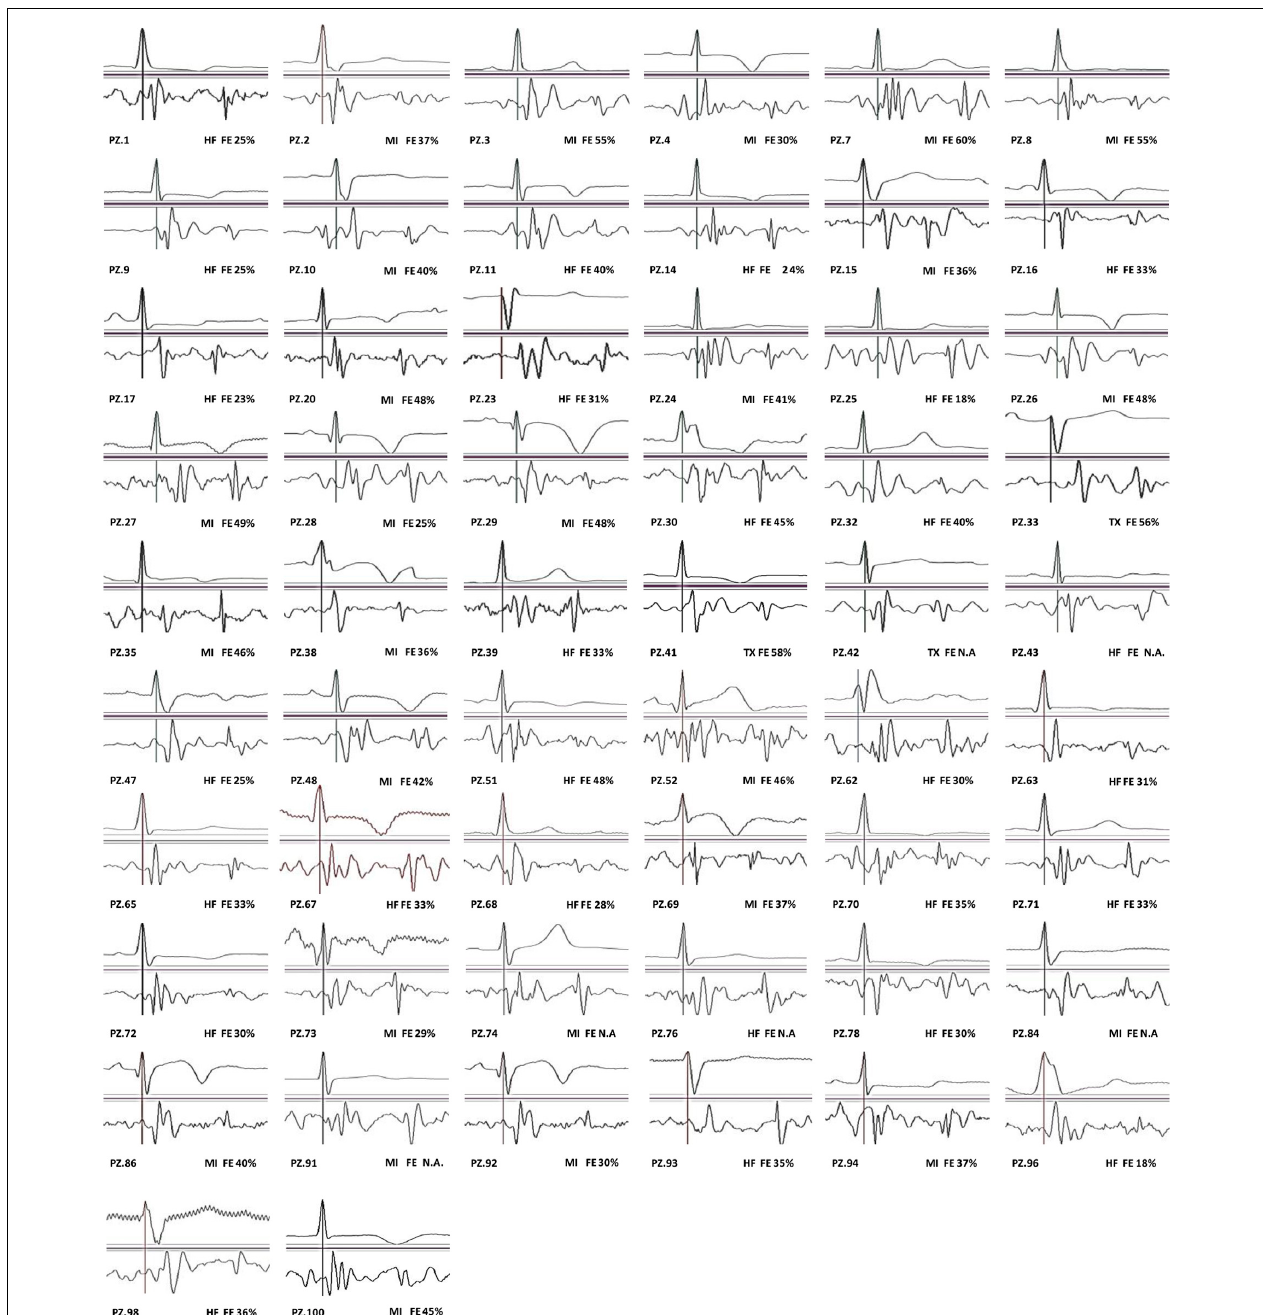
FIGURE 3 | SCG traditional (T)